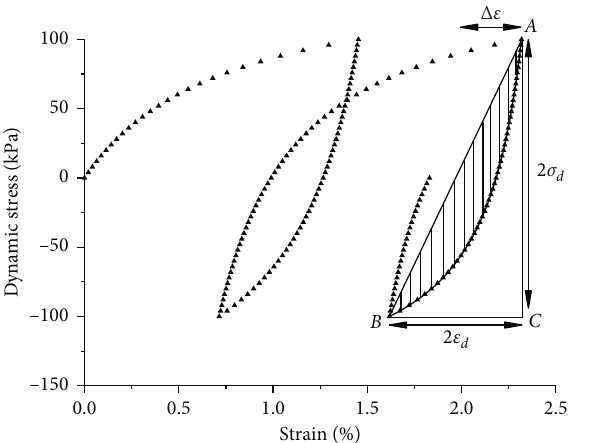
Figure 14: Nonclosed stress-strain hysteresis